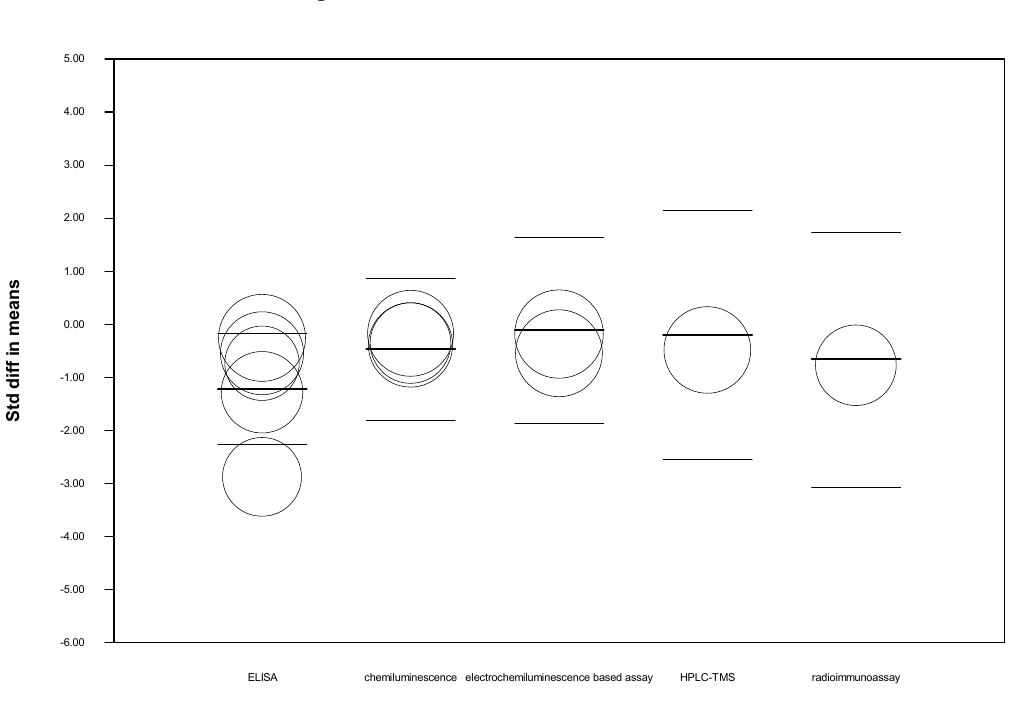
Figure 7. Cases vs. Controls: Scatterplot for method.